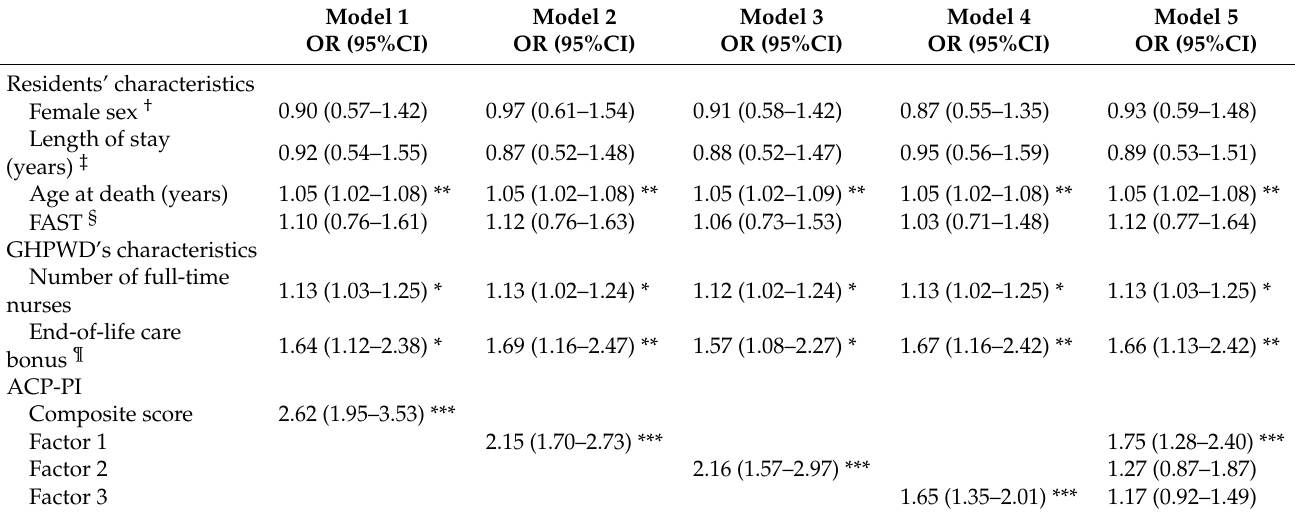
Table 6. Logistic regression for the residents’ quality of dying and related factors ( N =